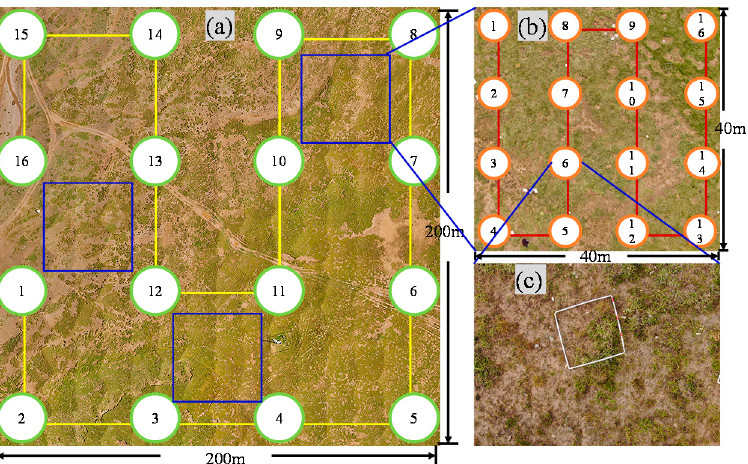
Figure 3. ( a ) Image shows the coverage area for aerial photographing and field sampling. There is one GRID flight way with 16 fixed way points; ( b ) photo shows the coverage area of the BELT flight way with 16 fixed way points; ( c ) picture presents the synchronous survey vegetation species composition by aerial photographing and traditional quadrat sampling. The white frame is the area for quadrat sampling with the size of 0.5 m × 0.5